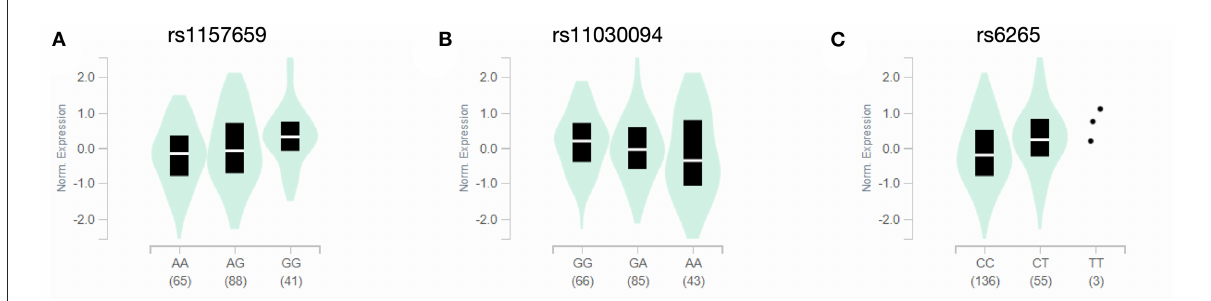
FIGURE3 BDNF transcript expression in caudate nucleus by SNP. Expression quantitative trait loci (eQTL) violin plots from the GTEx dataset depict normative BDNF transcript expression in the caudate nucleus for the rs1157659 (A) , rs11030094 (B) and rs6265 (C) SNPs, grouped by genotype. The horizontal white line represents the